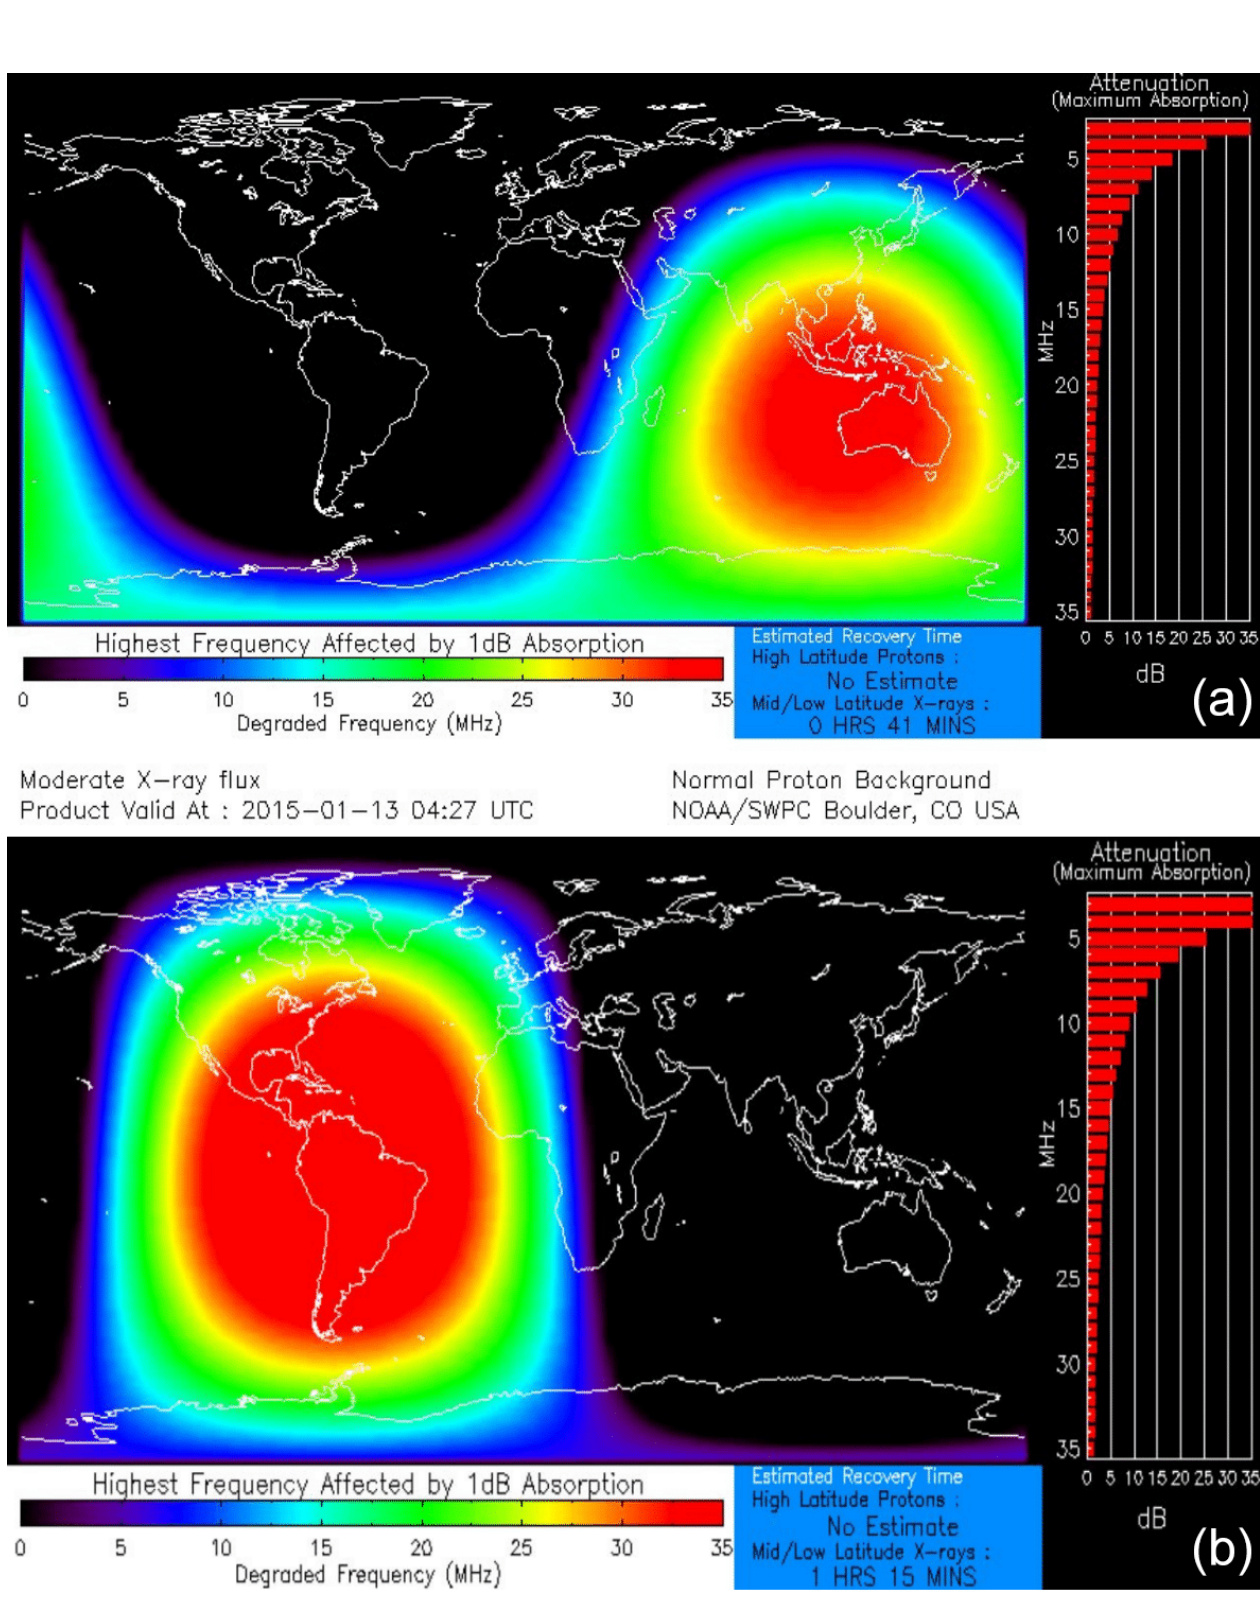
Figure 8. Maps with radio blackout on 13 January 2015 (a) and on 12 March 2015 (b) . Source: Space Weather Prediction Center (SWPC).